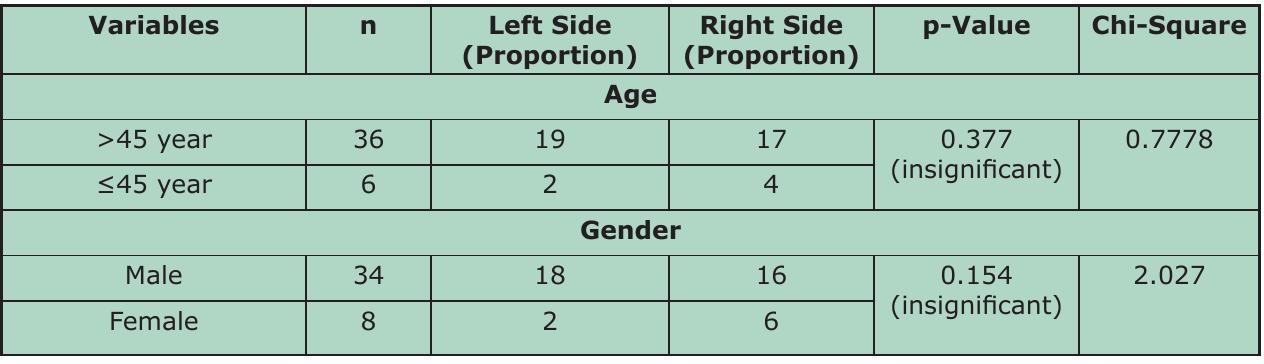
Table-II: Stratification of Left/Right Side Proportions in Age Groups and